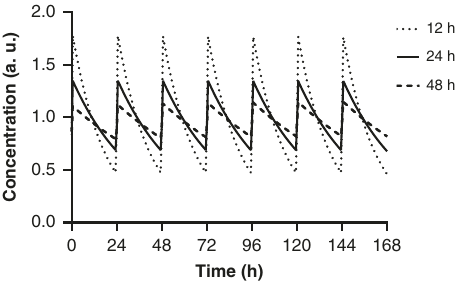
Fig. 1 In fl uence of half-life on peak to trough in steady state in dogs with once daily dosing. The simulations were based on data for OI338 tested in dogs and the PK pro fi les were normalized to the area-under-the-curve (AUC) for a 24-h period. Absorption and volume of distribution was kept constant and clearance was changed dependent of the elimination